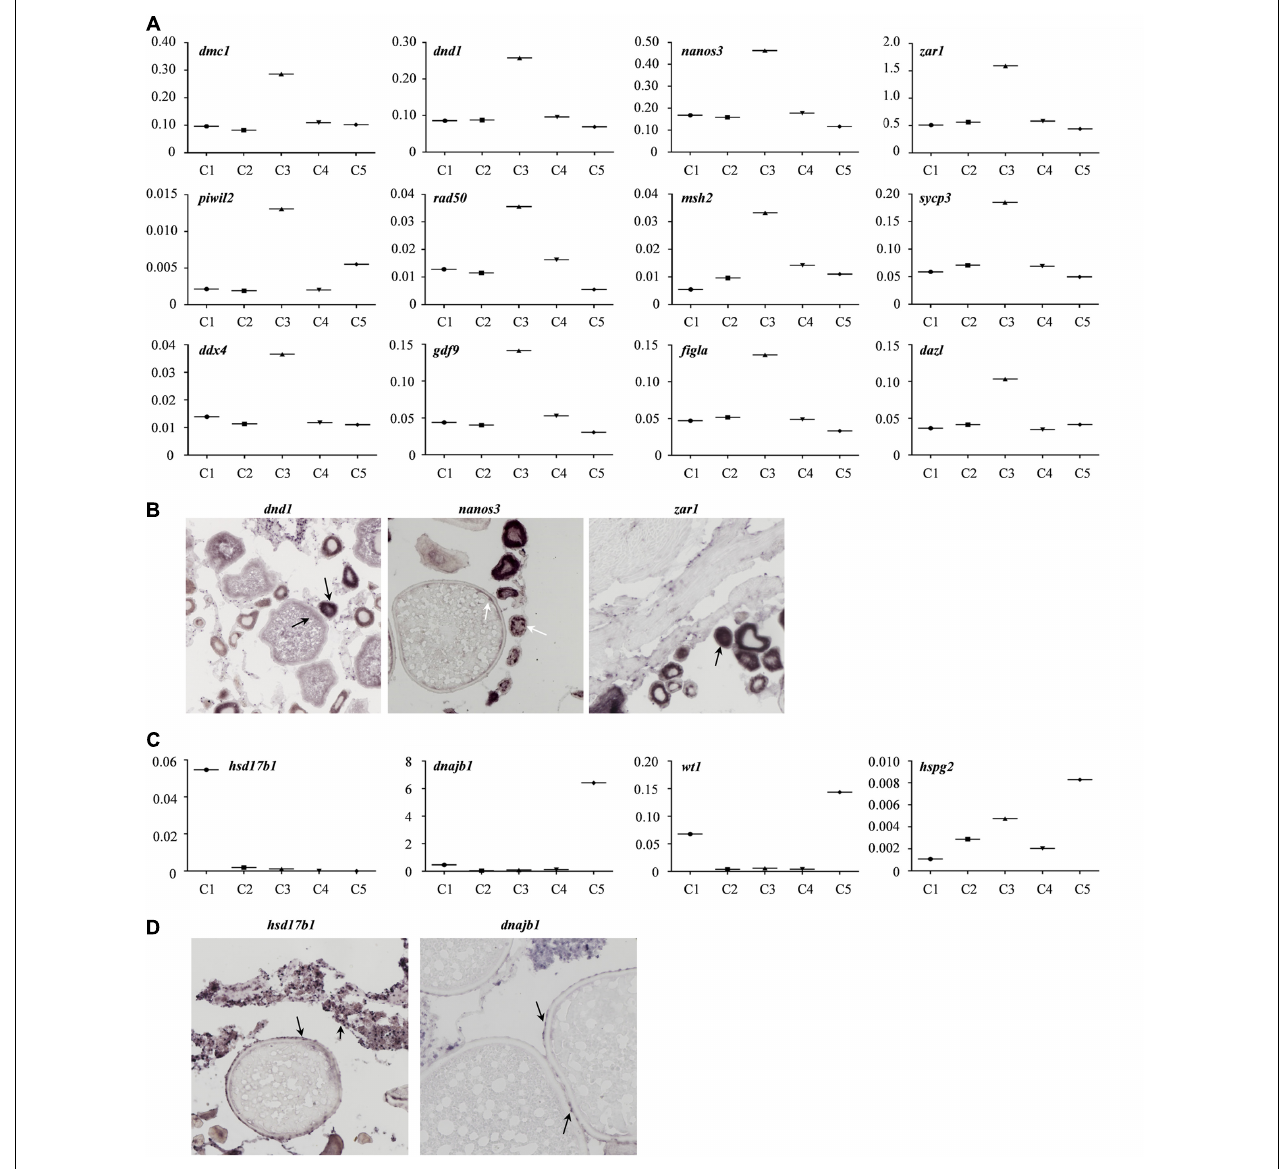
FIGURE 5 | Gene transcriptional characteristics in the ovary of Asian sea bass. (A) The expression profiles of the known germline-specific markers. logFold change represents the gene expression level. (B) ISH analysis of several marker genes transcription in germ cell cluster (cluster 3). The arrows indicate the signals of germ cell marker genes. (C) The expression profiles of the known somatic cell-specific markers. logFold change represents the gene expression level. (D) ISH analysis of several marker genes transcription in somatic cell cluster (cluster 5 and cluster 1). The arrows indicate the signals of somatic cell marker